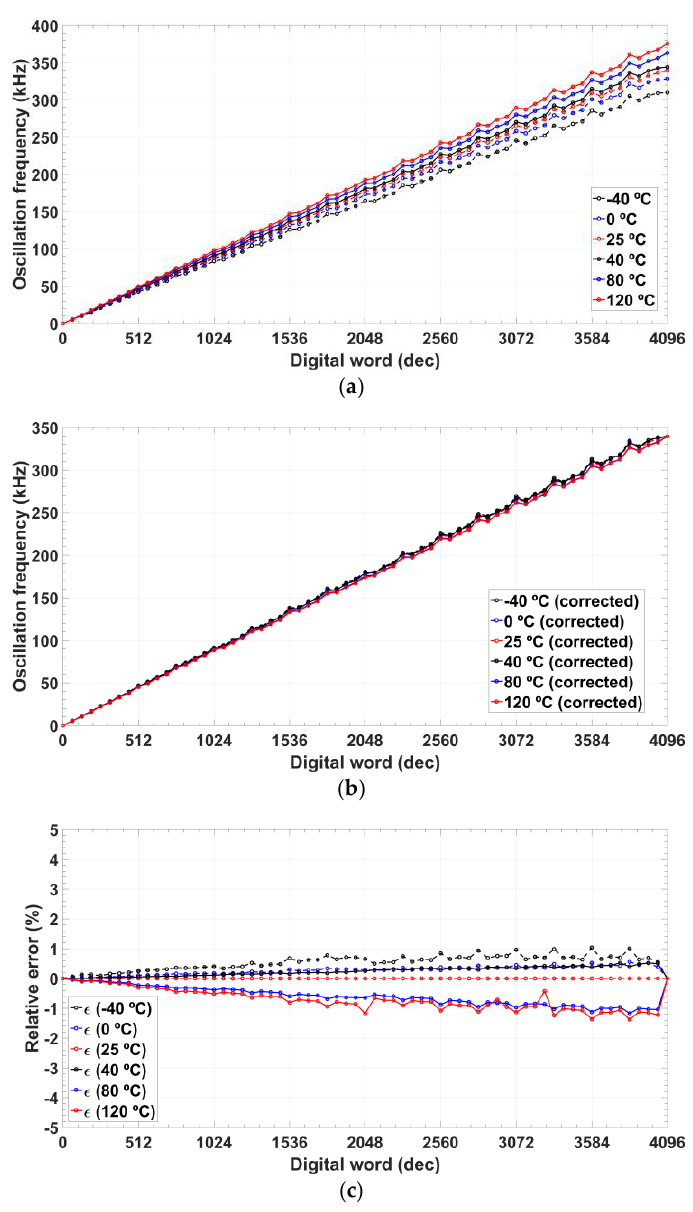
Figure 13. Oscillation frequency for a temperature range from −40 to 120 °C: ( a ) measured; ( b ) slope error corrected; and ( c ) relative error after correction.